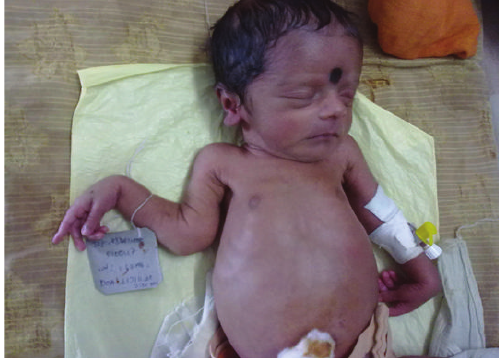
Figure 1: Swelling of both elbow joints.